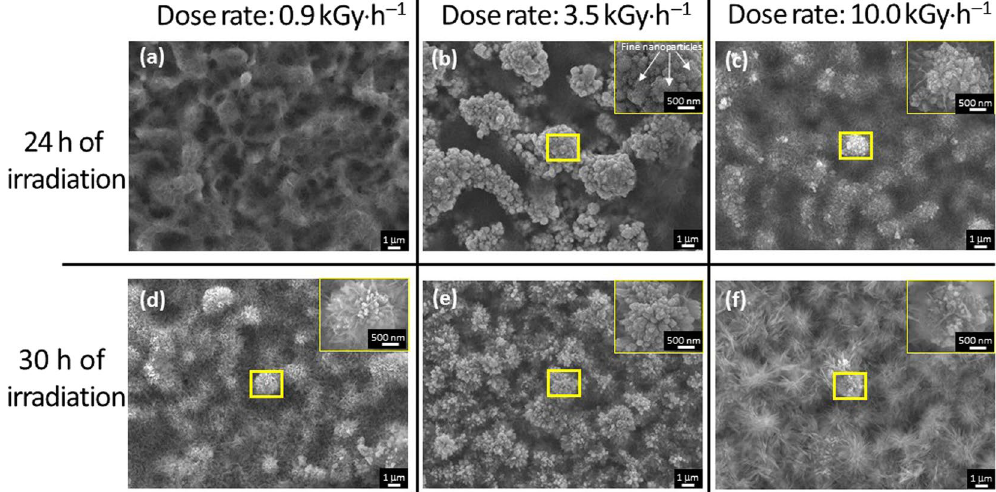
Figure 10. SEM images of the Zn plates after gamma-ray irradiation under different dose rates and irradiation times.